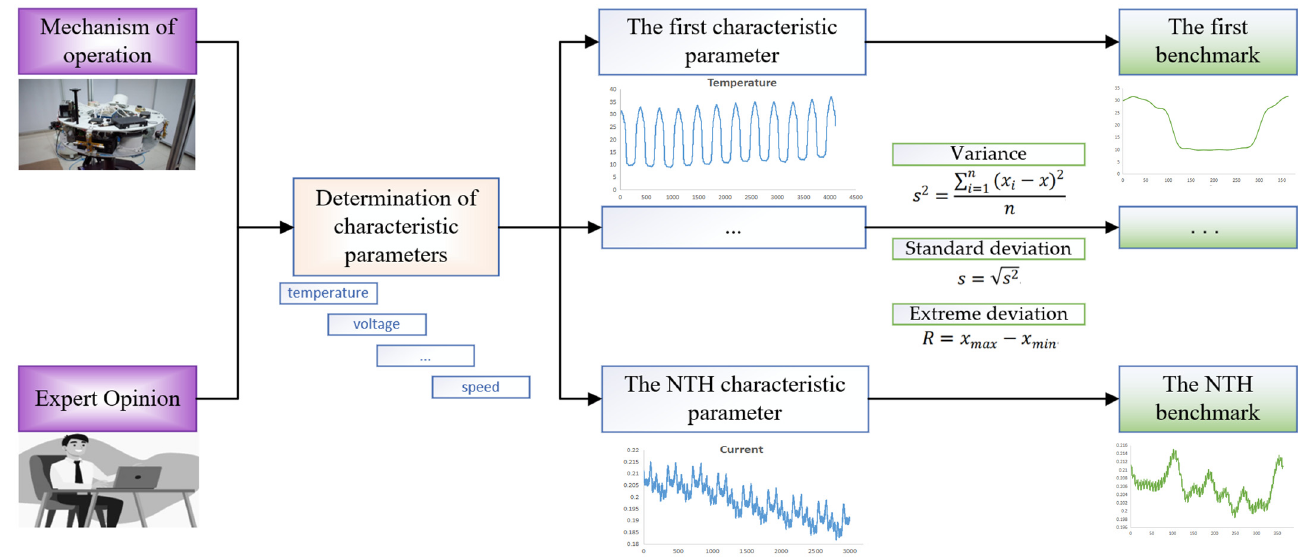
Figure 2. Selection of characteristic parameters and benchmarking methods.